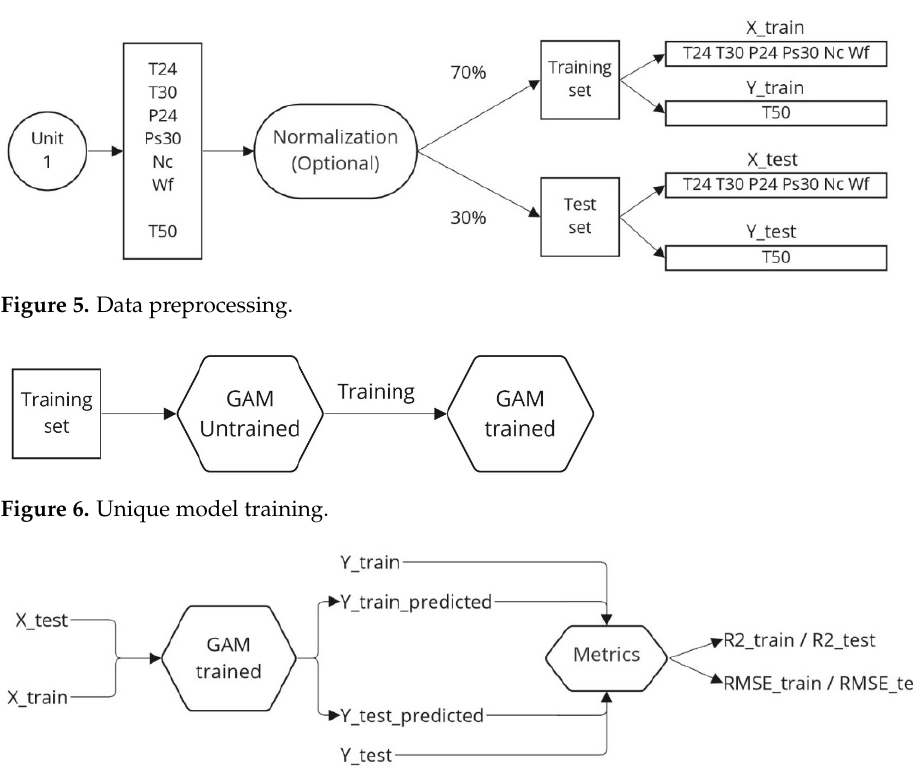
Figure 7. Model evaluation. Figure 7. Model